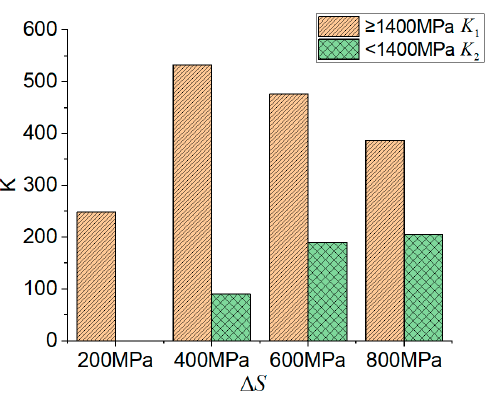
Figure 7. Test data.